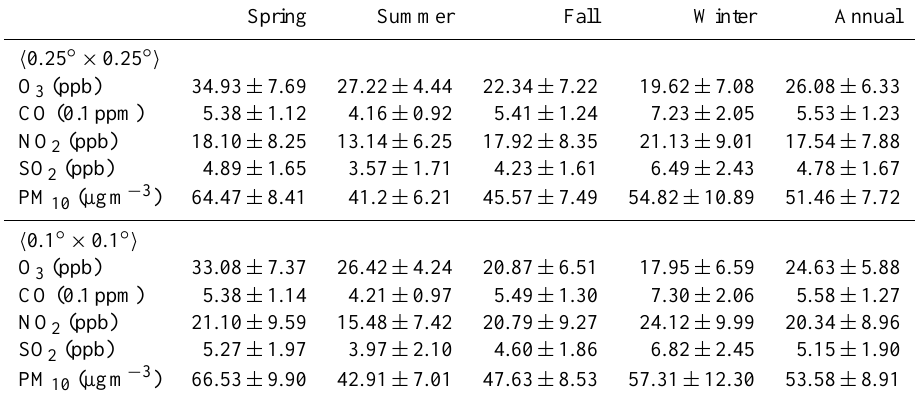
Table 5. Climatological averages of (a) O 3 (ppb), (b) CO (0.1ppm), (c) NO 2 (ppb), (d) SO 2 (ppb), and (e) PM 10 (µgm − 3 ) in two types of spatial grids (0 . 25 ◦ × 0 . 25 ◦ and 0 . 1 ◦ × 0 . 1 ◦ ) over South Korea during 2002–2013. The standard deviation ( σ ) values of the five kinds of variables are also presented with the ±